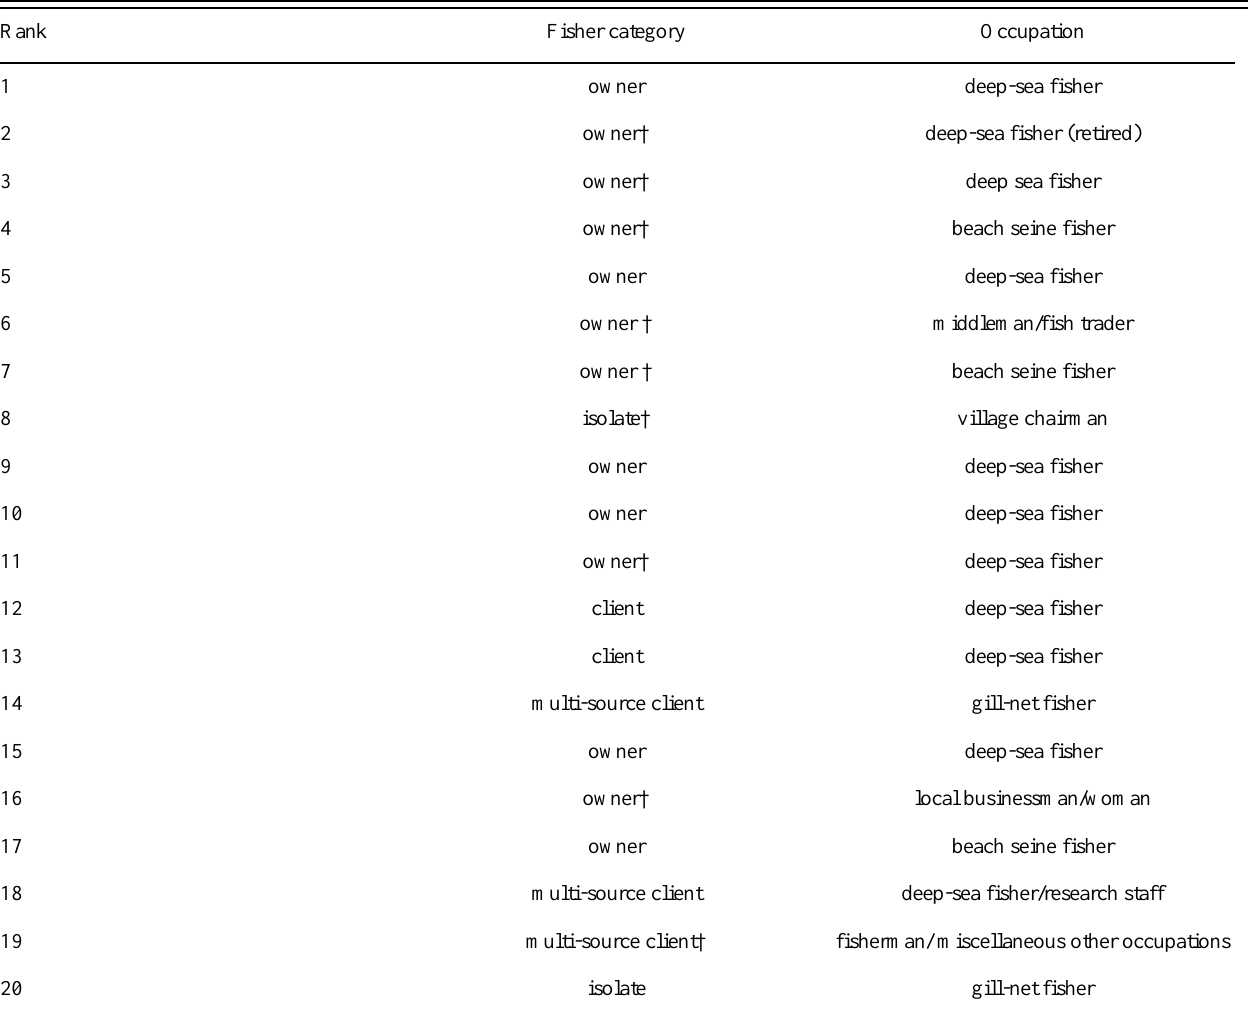
Table 3. List of individuals most highly ranked in the knowledge